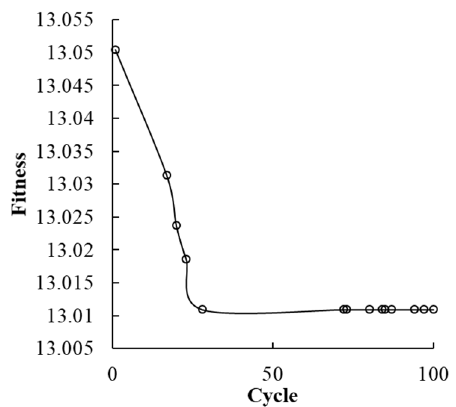
Figure 8. The convergence of the ABC-based approach.